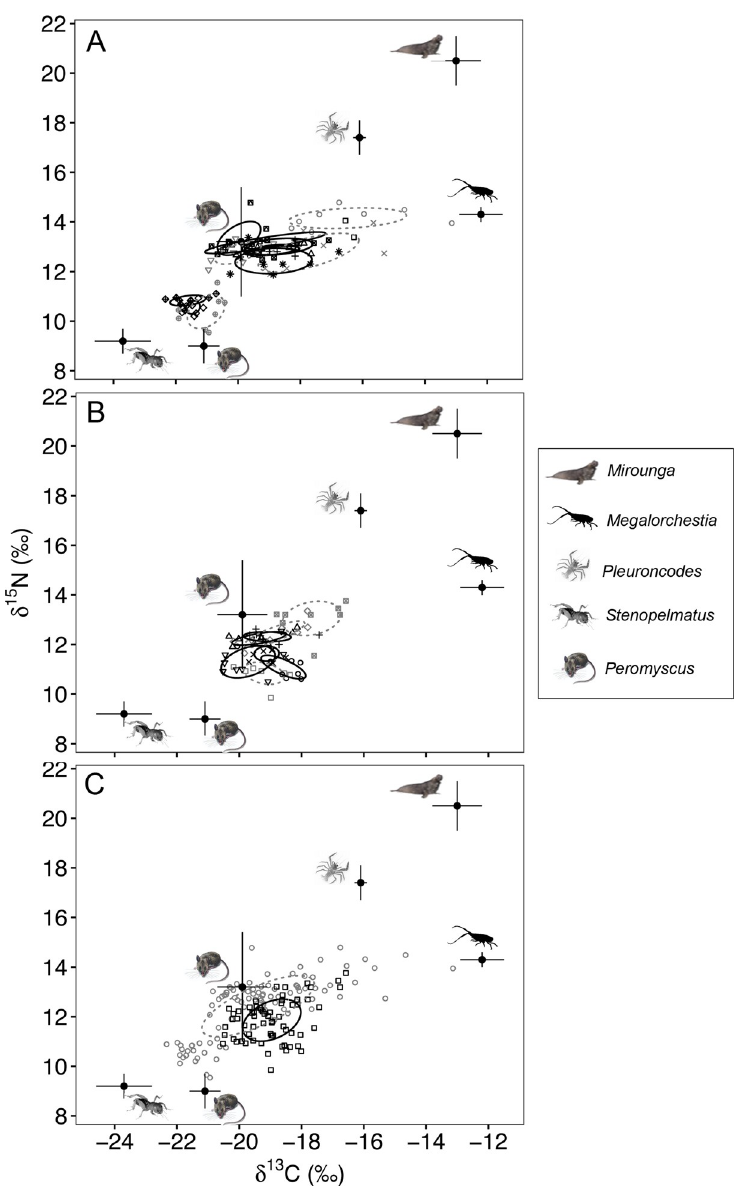
Fig 6. Bivariate plots of island fox whisker segment δ 13 C and δ 15 N values for Soledad and China Camp beaches. (A) Soledad and (B) China Camp beaches, and (C) comparison of populations from the two sites. The two beaches were sampled within two weeks of each other. Isotopic niche width visualized as standard ellipses enclosing 40% of the isotope space for individual foxes and for populations at each site. Dashed gray lines enclosing values for males, solid black lines enclosing females. Standard ellipse areas (SEA C and SEA B ) for individuals and each population are given in Table 3. Mean δ 13 C and δ 15 N values of potential foods, included for context, are adjusted upward to account for expected trophic discrimination between fox and food (TDFs: Δ 13 C = 2.6‰ and Δ 15 N = 3.4